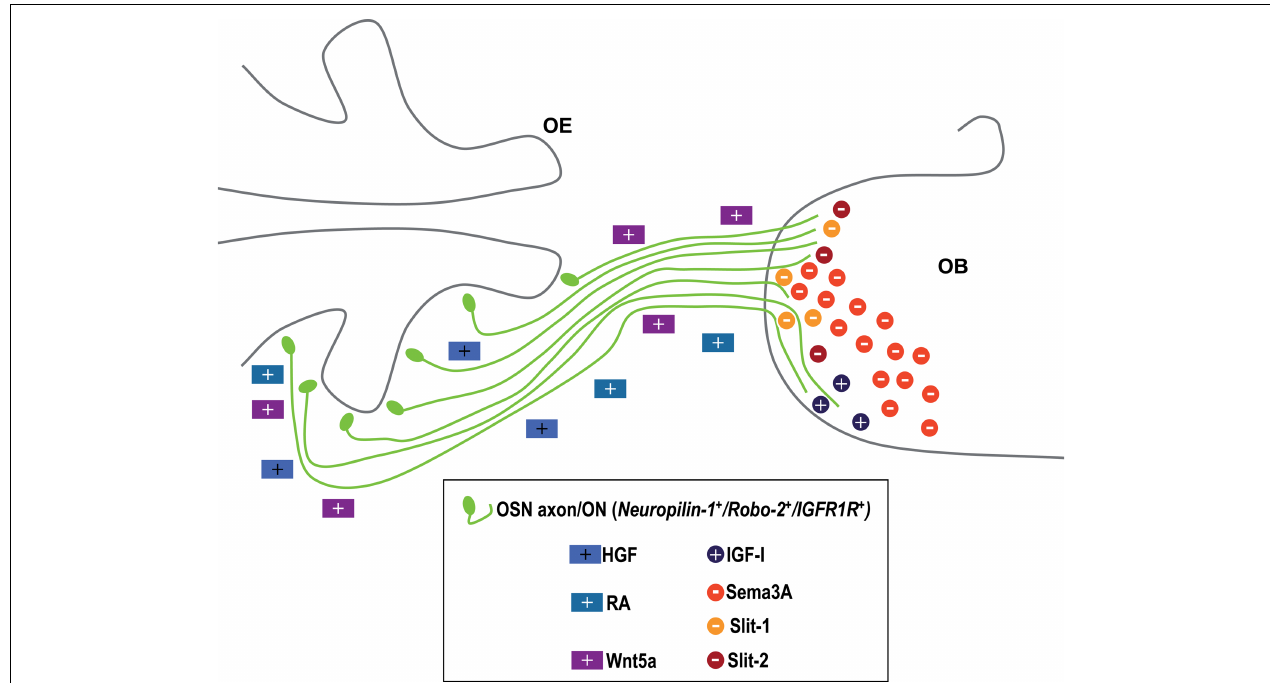
FIGURE 2 | Secreted cues involved in the formation of the olfactory nerve. The OSNs are located in the olfactory epithelium, and their axons project to the olfactory bulb (OB) to form the olfactory nerve (in green). Axonal elongation depends on the action of retinoic acid (RA), Wnt5a and hepatocytic growth factor (HGF), all of them represented as coloured squares. Once in the OB,